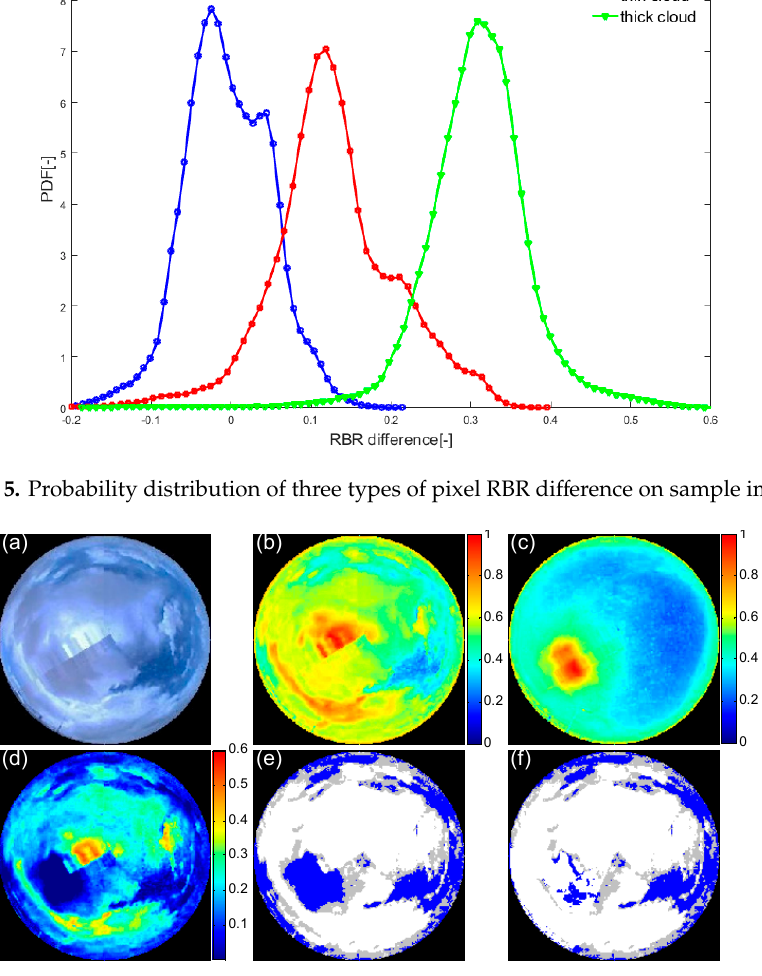
Figure 6. Process of cloud detection ( a ) image at 15:10 on 7 May 2015 at SZA = 58 ◦ , SAA = 239 ◦ (solar azimuth). ( b ) RBR image. ( c ) The background RBR image at 15:13 on 7 May 7 at SZA = 58 ◦ , SAA = 239 ◦ . ( d ) RBR di ff erence of ( b , c ). ( e ) Output of cloud detection. ( f ) Cloud map corrected by SP (sun parameter) (SP = 0.78), white: thick cloud, gray: thin cloud, blue: clear sky.